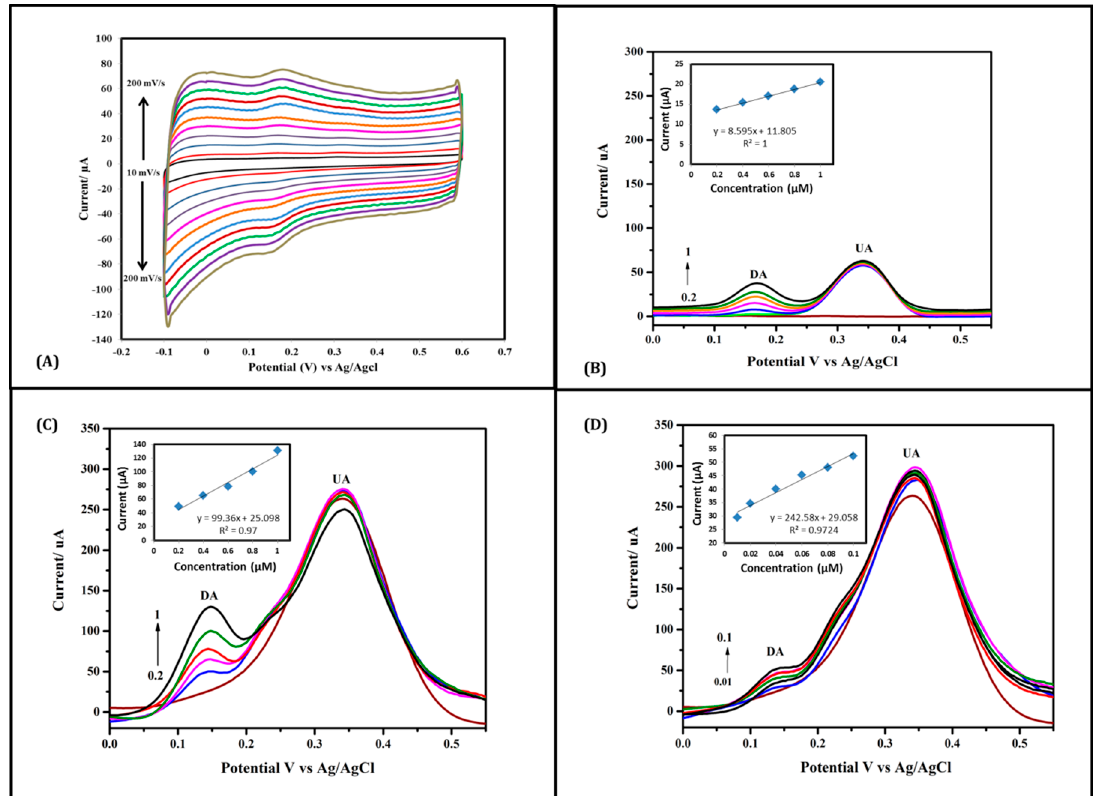
Figure 3. Electrochemical investigation of Nafion-coated MWNT yarn ( A ) CVs of 10 µM DA with 200 µM AA & UA (each) at scan rates: 10, 20, 40, 60, 80, 100, 120, 140, 160, 180, and 200 mv/s. ( B ) DPV of thick layer Nafion in 200 µM UA & AA each with a range of DA: (0.2, 0.4, 0.6, 0.8, and 1) µM in PBS electrolyte with Calibration curve plot between DA concentrations and current response. ( C ) DPV of thin layer Nafion in 200 µM UA & AA with DA range: (0.2, 0.4, 0.6, 0.8, and 1) µM in PBS electrolyte with the calibration curve plot between DA concentrations and current responses ( D ) DPV of thin layer Nafion in 200 µM UA & AA with a range of DA: (0.01, 0.02, 0.04, 0.06, 0.08, and 0.1) µM in PBS electrolyte with the calibration curve plot between DA concentrations and current response.